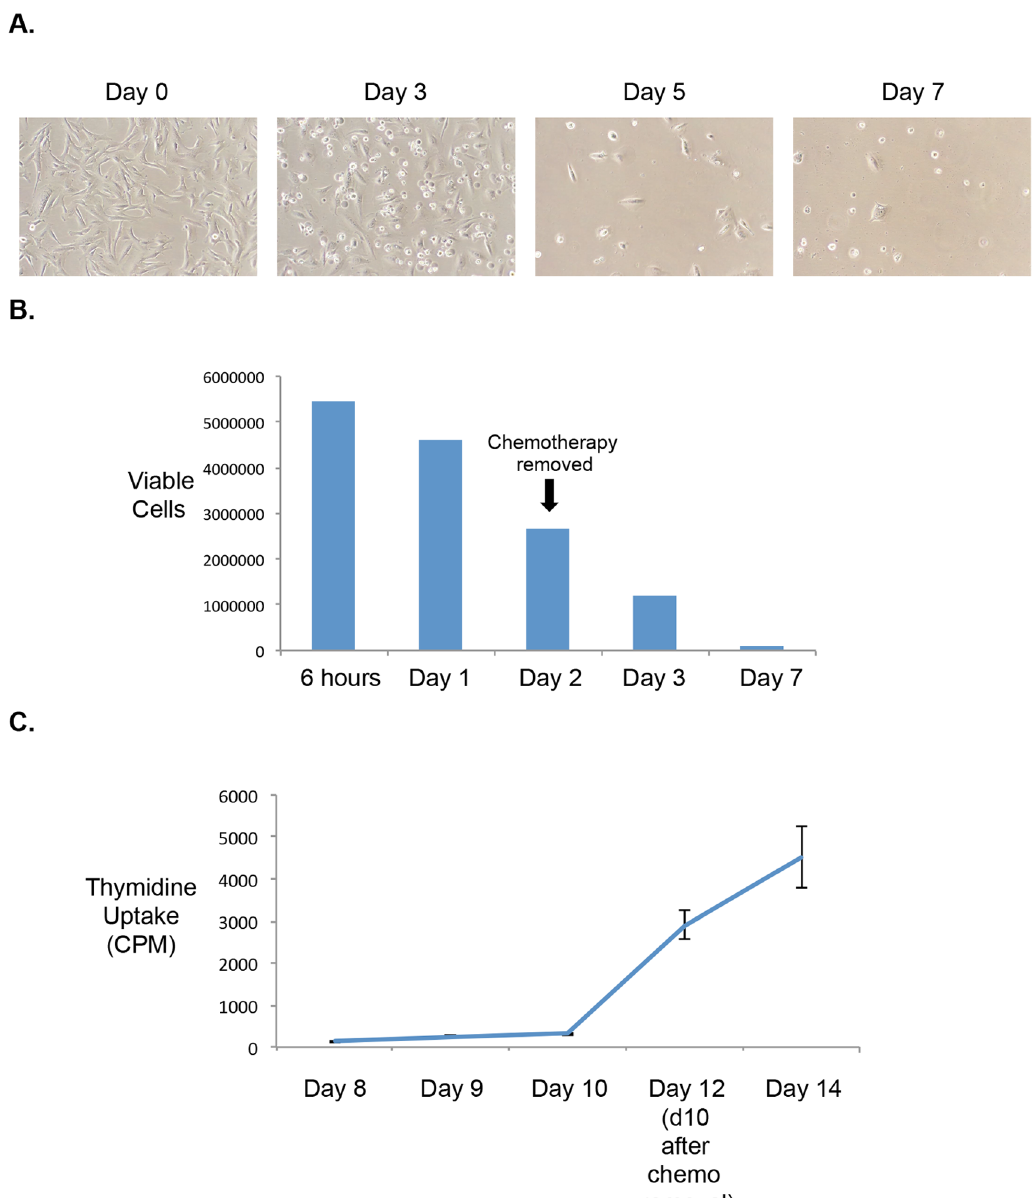
Figure 3. Kinetics of ‘‘recurrent’’ colony growth. SUM159 tumor cells were incubated with Doxorubicin (2d) as indicated in Fig. 1. A and B. Kinetics of cell die-off were assessed by imaging representative fields ( A ) as well as by counting viable cells using trypan blue ( B ) at the indicated times post-chemotherapy treatment. C. Proliferative status of residual tumor cells was measured over time by performing thymidine incorporation assays on cells (2000 cells/well) harvested at the indicated times post-chemotherapy treatment.